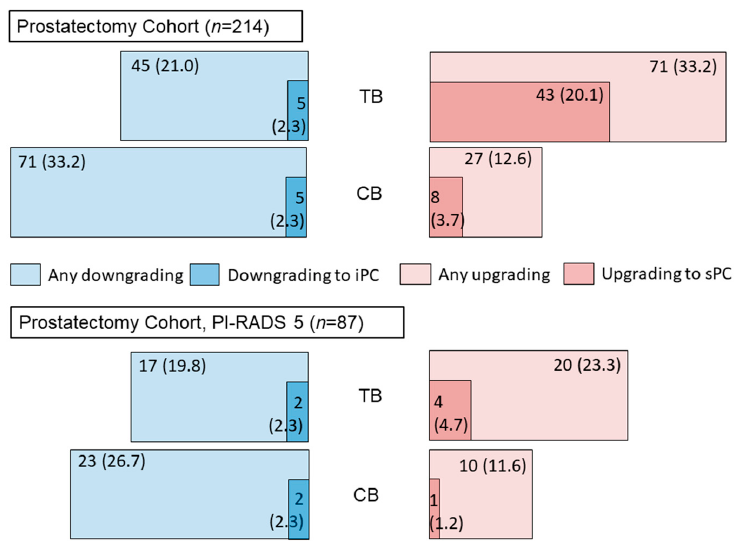
Figure 3. Reclassification rates of ISUP grade groups between prostate biopsy and a subsequent radical prostatectomy. For the whole prostatectomy cohort, combined biopsy mode (CB, MRI-targeted biopsy + synchronous systematic biopsy) reduced the upgrading to significant prostate cancer from 20.1% when considering MRI-targeted biopsy (TB) results only to 3.7%. For the subgroup of PI-RADS 5 men this effect turned neglectable (4.7% vs. 1.2%). iPC—indolent prostate cancer; sPC—significant prostate cancer; PI-RADS—Prostate Imaging Reporting and Data System; Length of bars is calculated by the respective percentages.